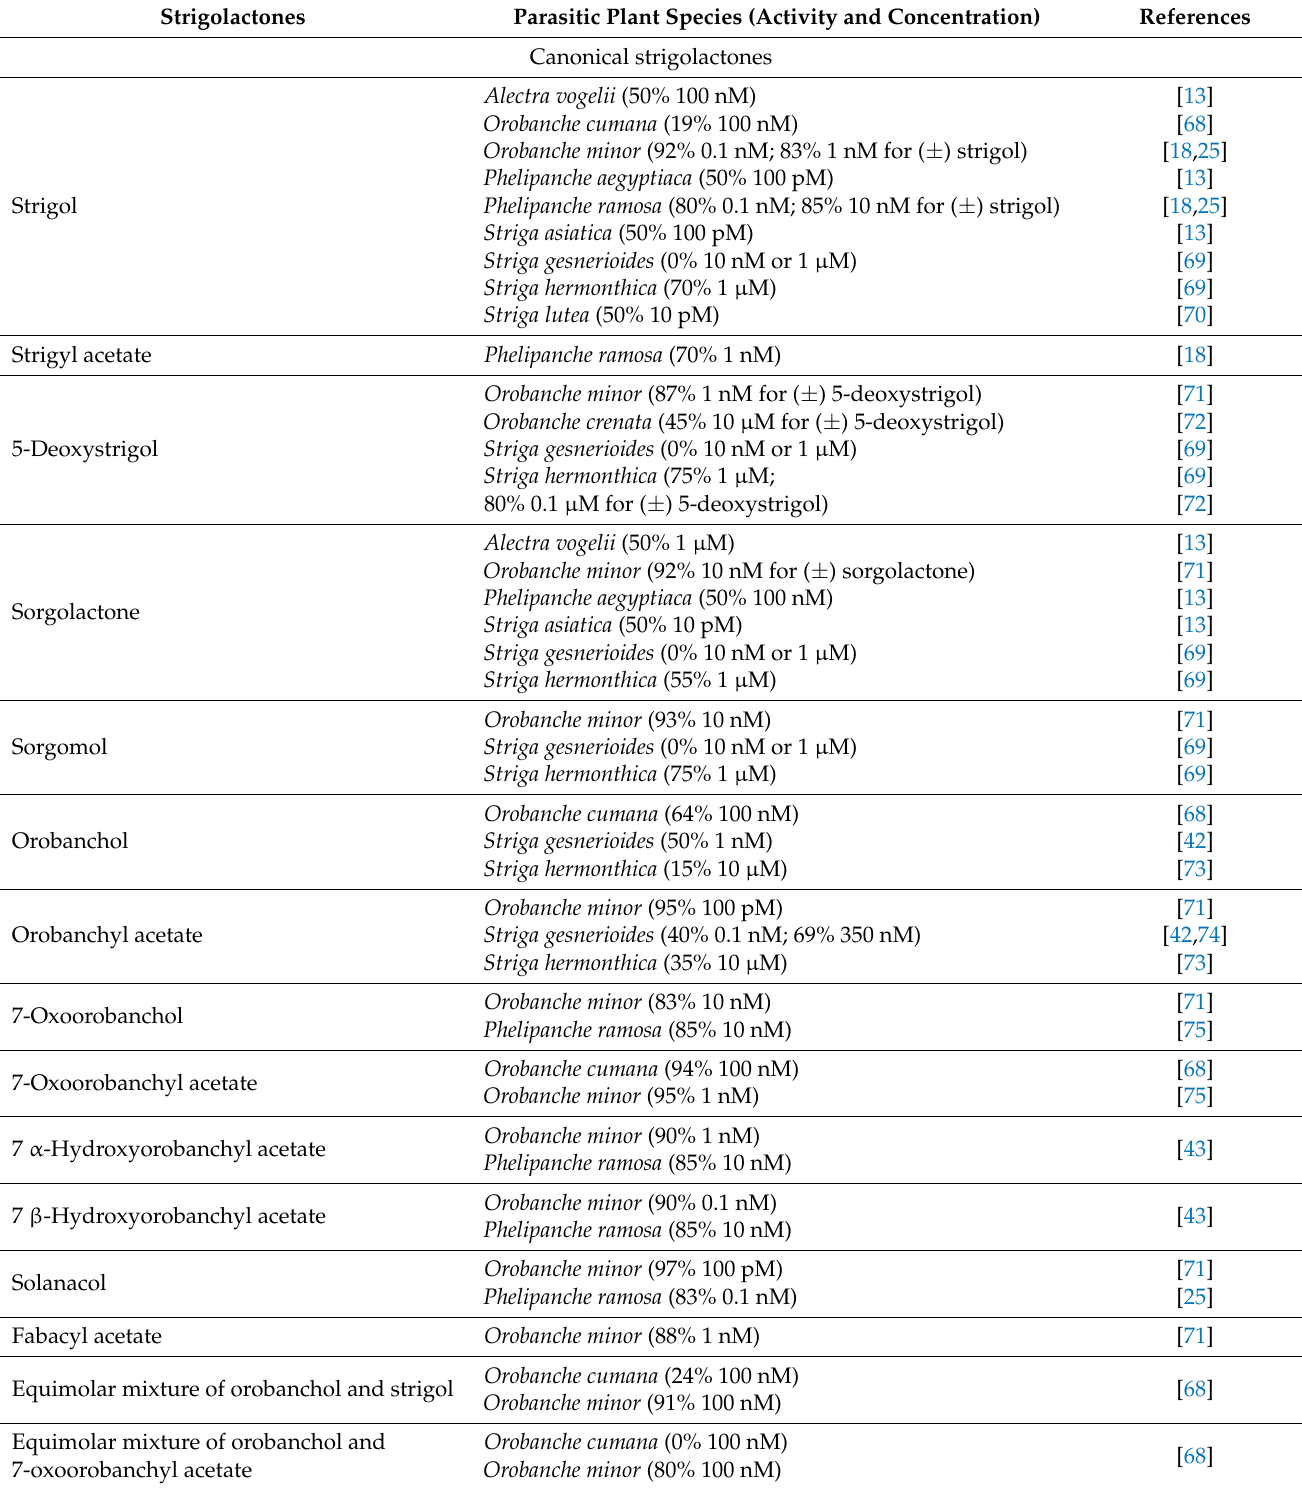
Table 2. Extension and update on the maximum germination stimulation activity data described for strigolactones since the review by ´Cavar et al. (2015)